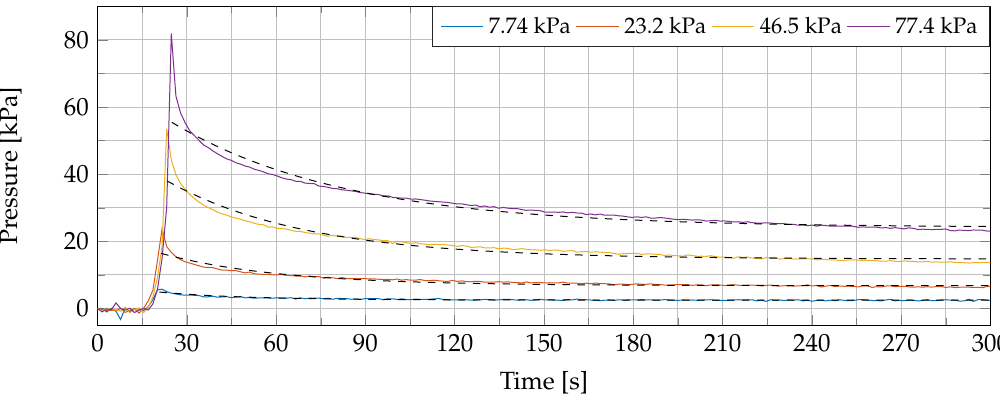
Figure 3. The exponential decaying behavior of the tissue: the tissue starts to conform according to the probe tip after applying an initial pressure. The decaying process is fitted with an exponential model and represented with dashed black